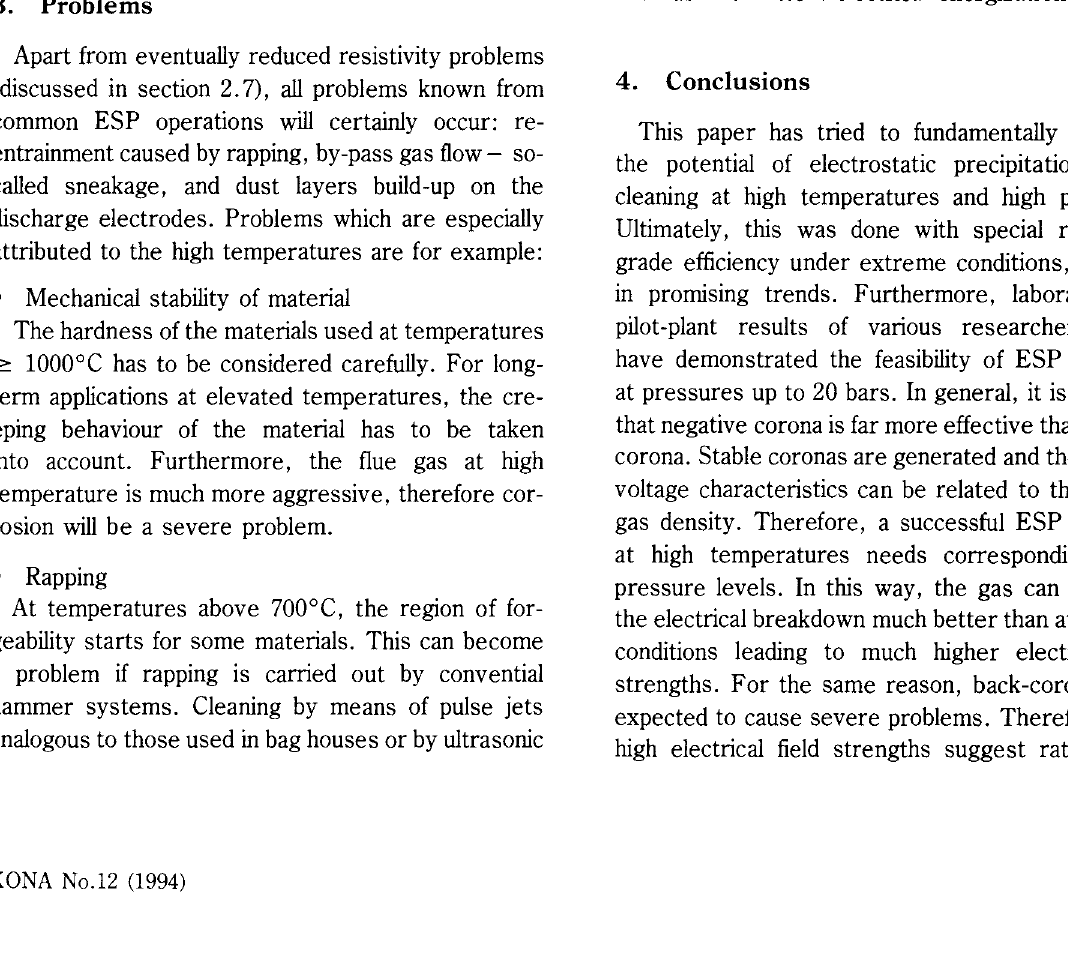
Fig. 20 Electrical resistivity trend of fly ash at high temperature levels measured by Arras/Mayer-Schwinning